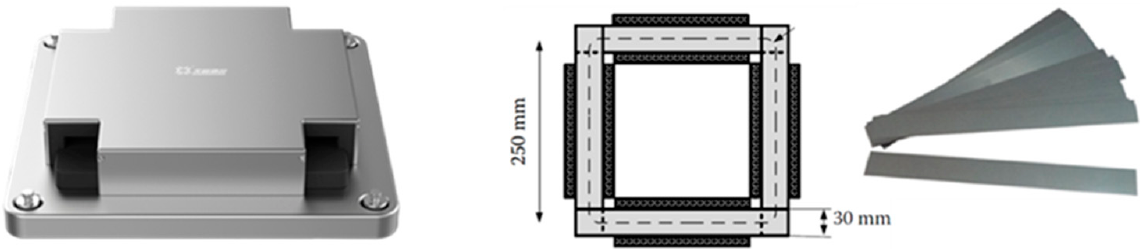
Figure 1. Setup and schematic diagram of the 25 cm Epstein tester and sample geometry.